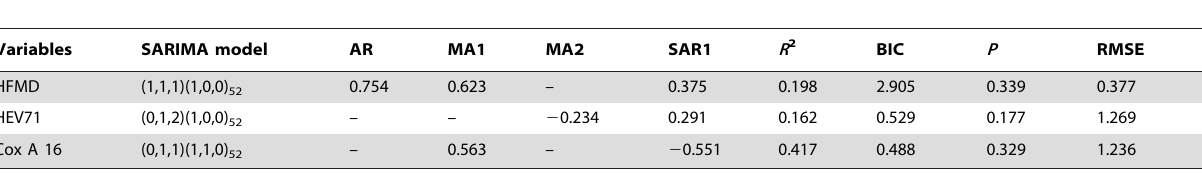
SARIMA: Seasonal Autoregressive Integrated Moving Average model, AR: autoregressive, MA: moving average, SAR: seasonal autoregressive, R 2 : Stationary R-squared, BIC: Bayesian information criteria, P : Ljung-Box test, RMSE: Root Mean Square